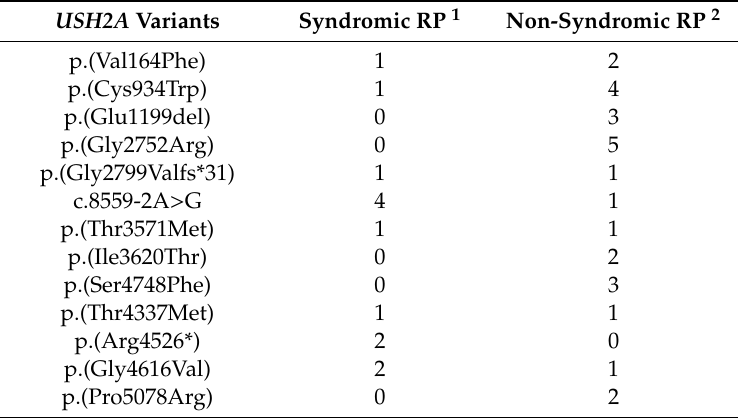
Table 4. USH2A variants detected in this study.